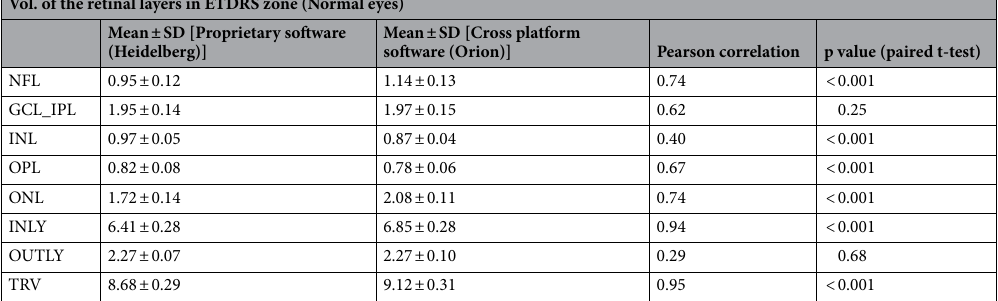
Vol. of the retinal layers in ETDRS zone (Normal